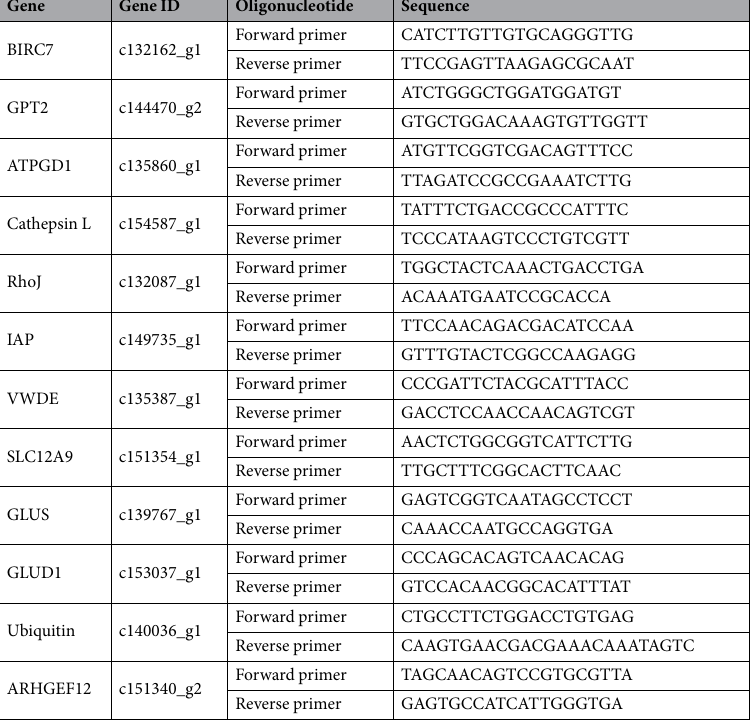
Table 5. Combination of primers used in RT-qPCR assays.